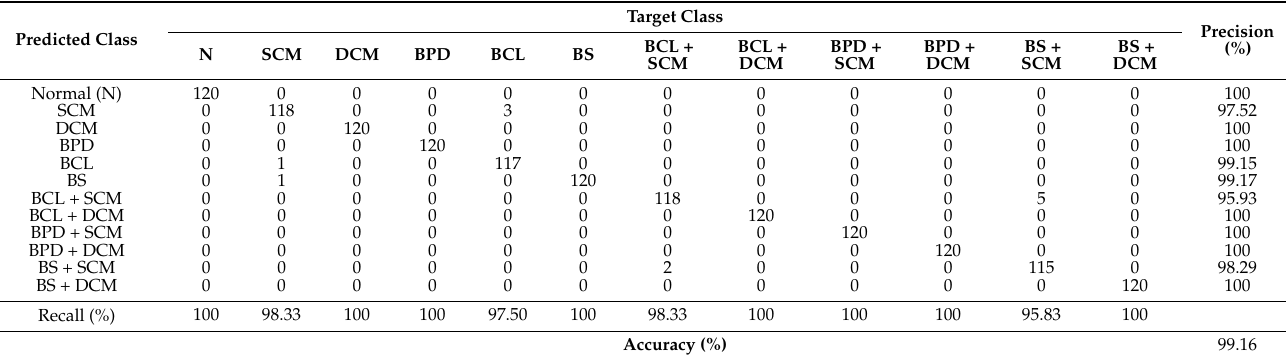
Table 7. Confusion matrix—FD